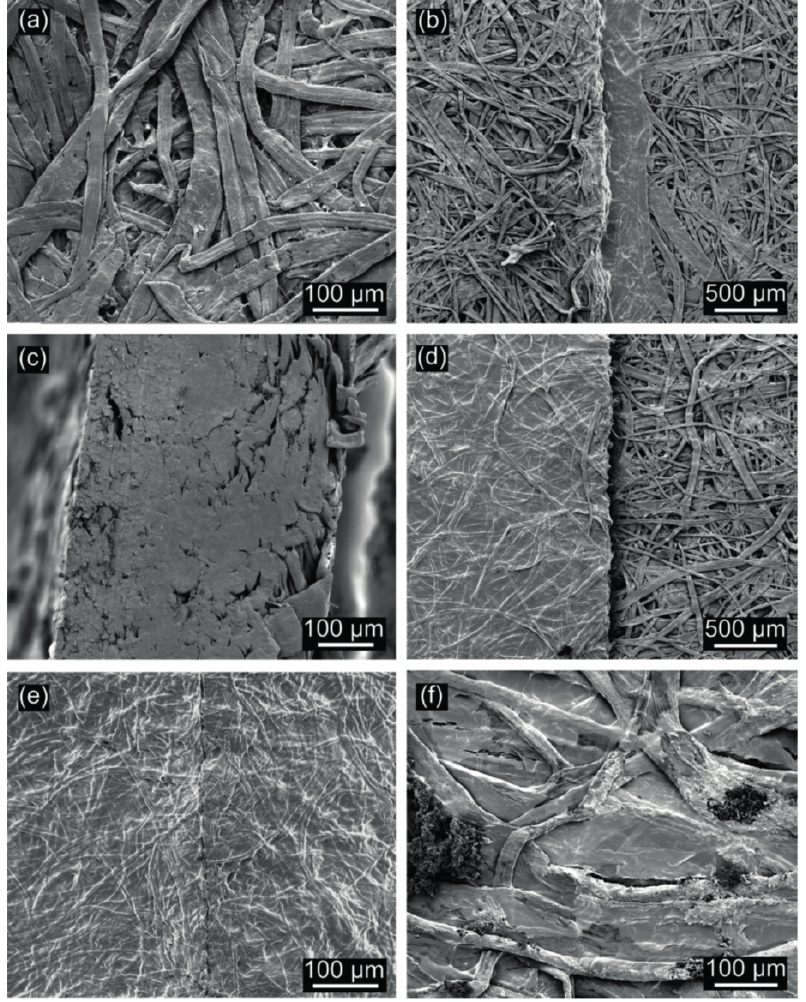
Figure 3 - Secondary electron micrographs showing results of the application of dissolved cellulose to filter paper: ( a ) as-received filter paper surface; ( b ) filter paper strips bonded with cellulose adhesive, single lap joint surface; ( c ) cross-section view of b; ( d ) single lap joint prepared with wet paper strips; ( e ) butt joint; ( f ) impregnated single strip. Reprinted (adapted) with permission from (Ferreira et al. 2015). Copyright 2015 American Chemical